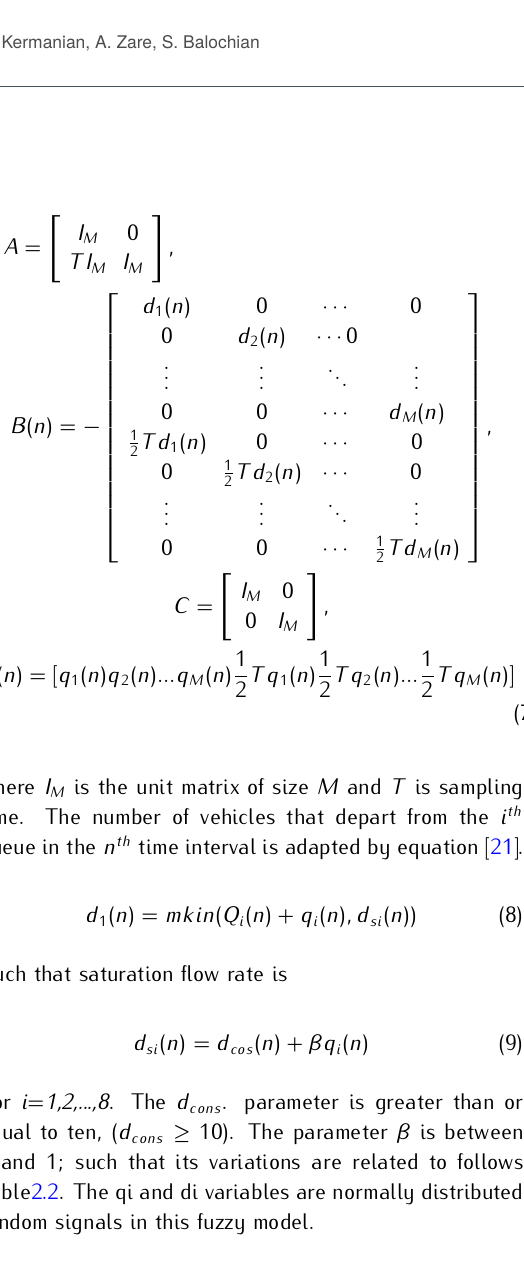
Table 1. The position of traffic by variable of β [21] Position of